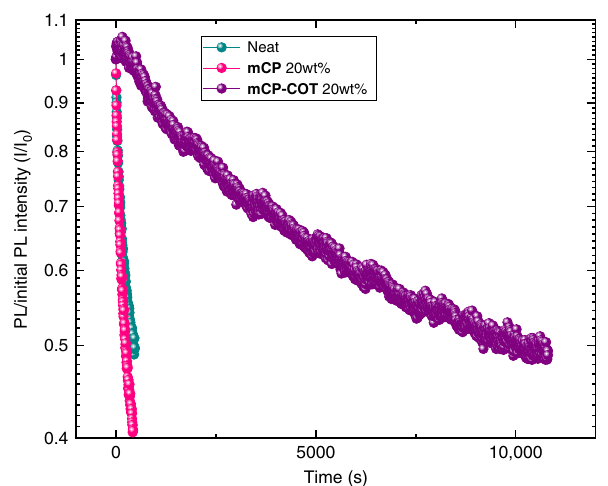
Fig. 5 Photostability of BSBCz-EH in neat and blend fi lms. PL intensity/ initial PL intensity ( I / I o ) of a BSBCz-EH neat fi lm (green line), a blend fi lm with 20 wt% mCP (pink line), and a blend fi lm with 20 wt% mCP-COT (violet line) measured under CW photoexcitation with a power of 200